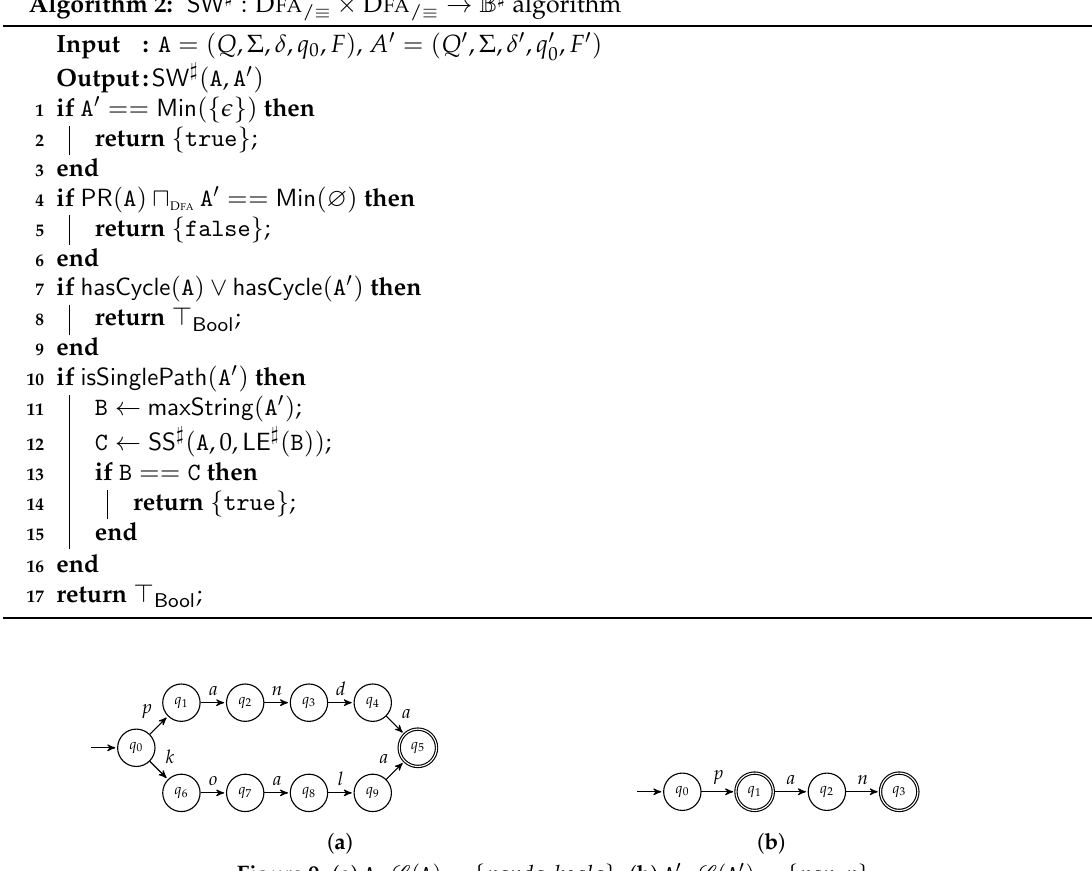
Algorithm 2: SW (cid:93) : D FA / ≡ × D FA / ≡ → B (cid:93) algorithm